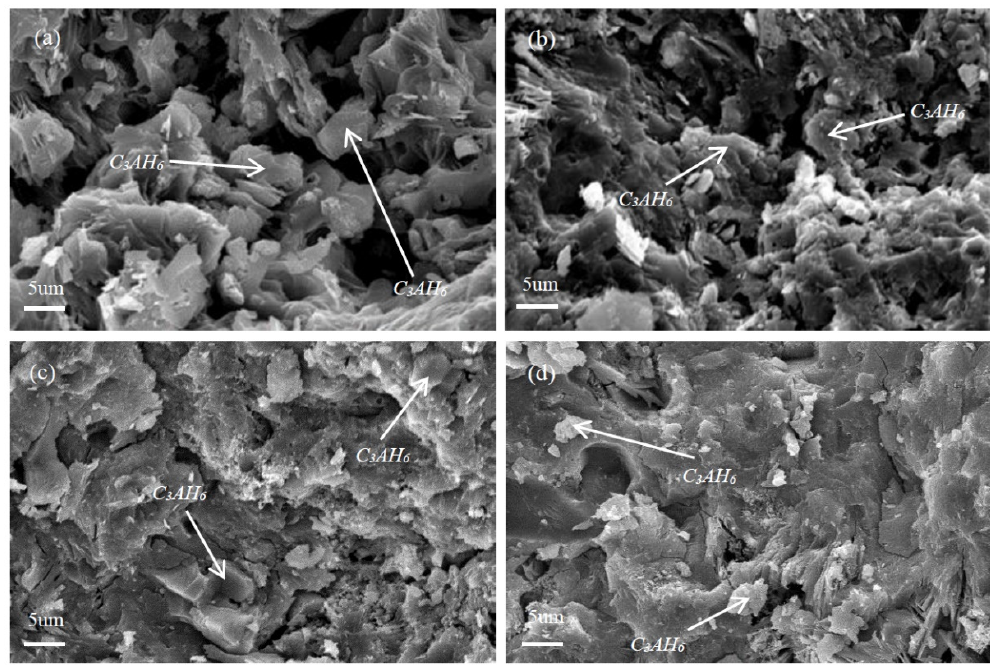
Figure 8. Scanning electron microscopy (SEM) images of PCAC after 1 d hydration: ( a ) without SHMP, ( b ) with 0.05% SHMP, ( c ) with 0.1% SHMP, and ( d ) with 0.2% SHMP.